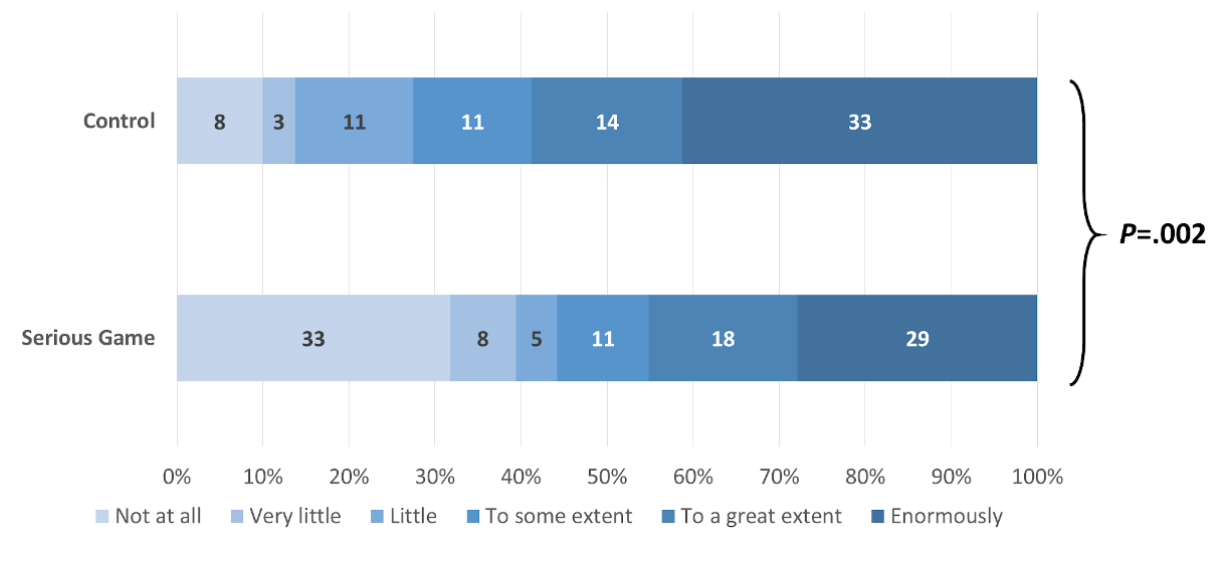
Figure 10. Magnitude of the willingness to change workplace disinfection behavior.